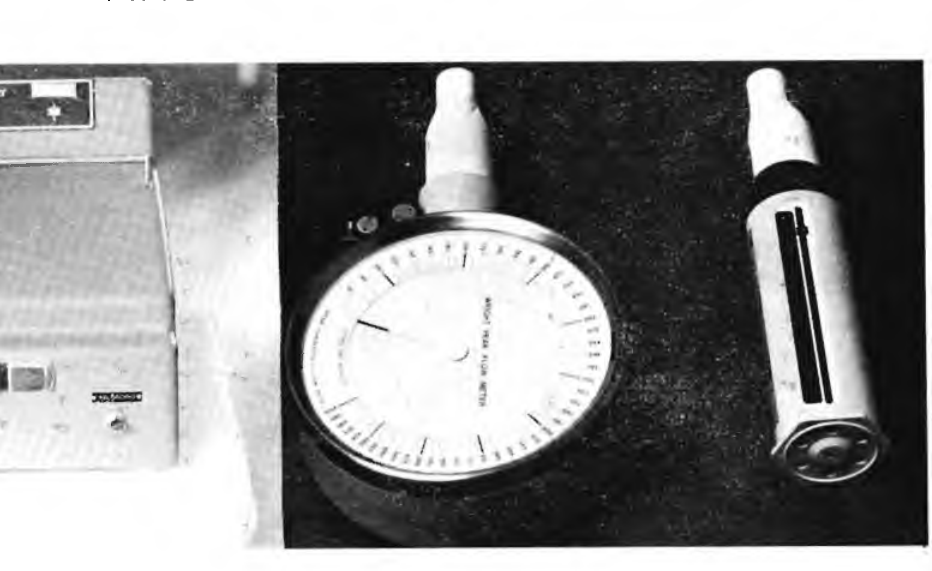
Fig. 4. W right's Peak Flow Meter (left) and Wright's Mini Peak Flow Meter